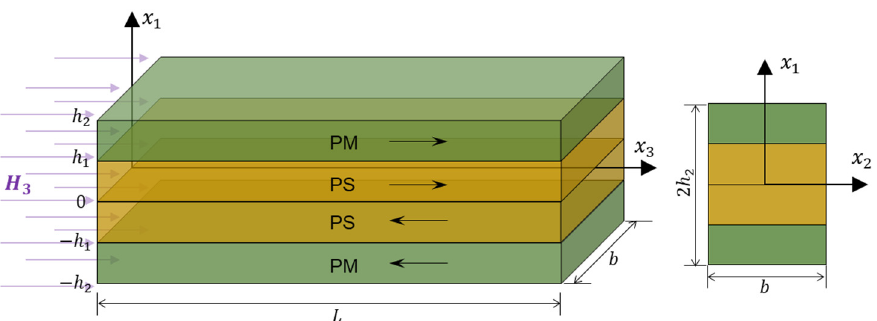
Figure 1. Sketch of an LMPS beam under the longitudinal magnetic field.